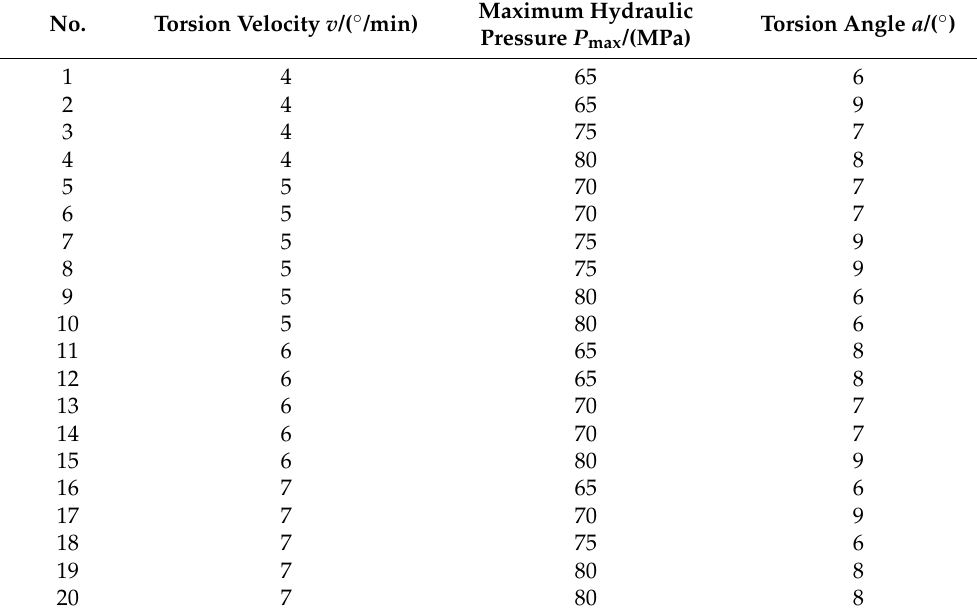
Table 4. Orthogonal torsion experiment scheme (input value of BP neural network).